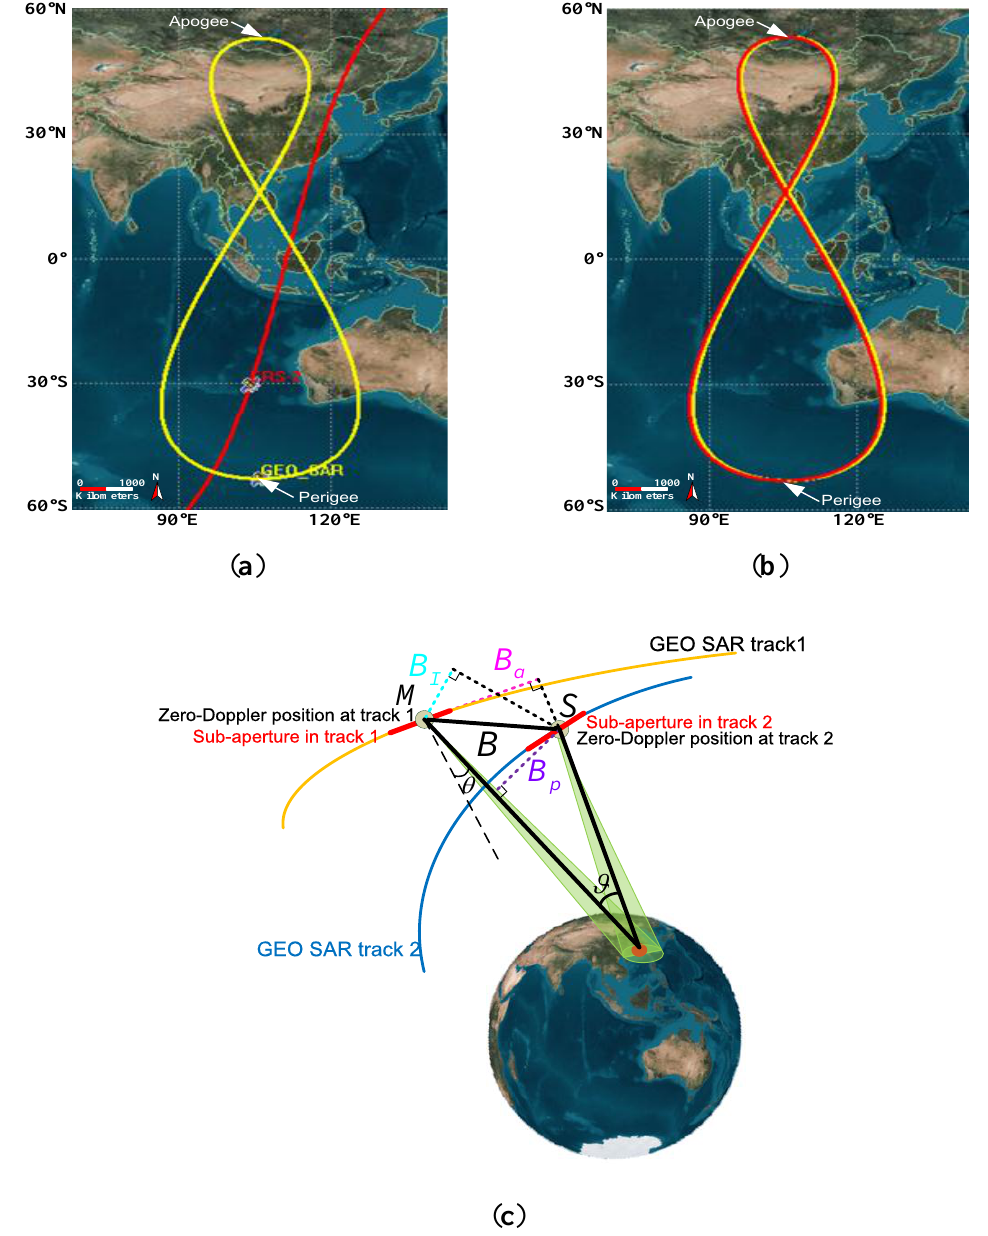
Figure 1. ( a ) Nadir-point trajectories of ERS-2 (red) and GEO SAR (yellow); ( b ) nadir-point trajectories of GEO InSAR repeated trajectories (the red line is the first track, and the yellow one is the second track after ten days); ( c ) three-dimensional (3D) sketch map of GEO InSAR repeated